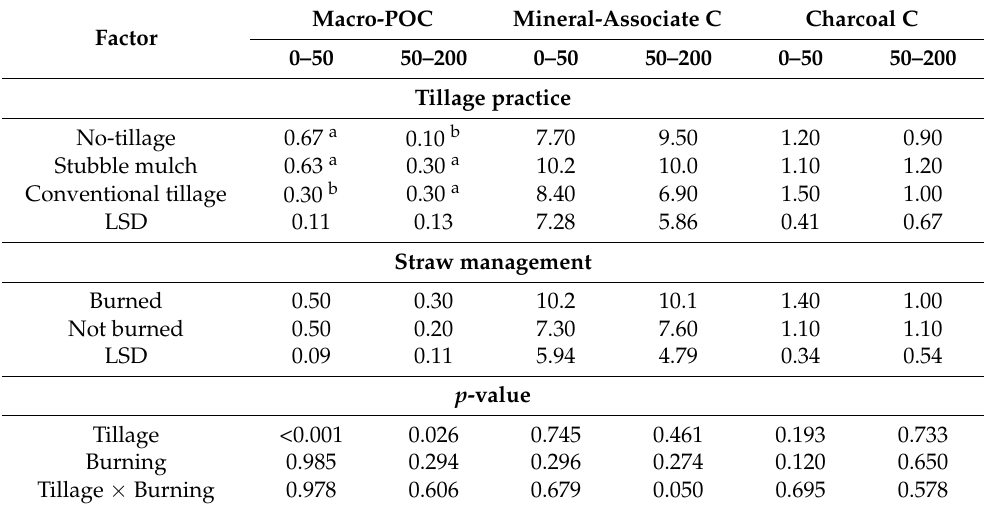
Table 2. The effect of tillage and straw management on carbon that was associated with macro- particulate organic matter, minerals, and charcoal (g kg − 1 ) in the 0–50 and 50–200 mm layers.